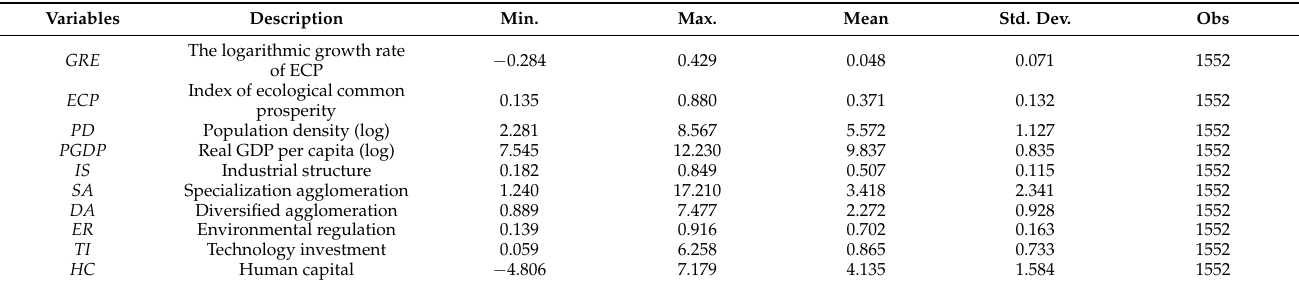
Table 2. The description of variables.